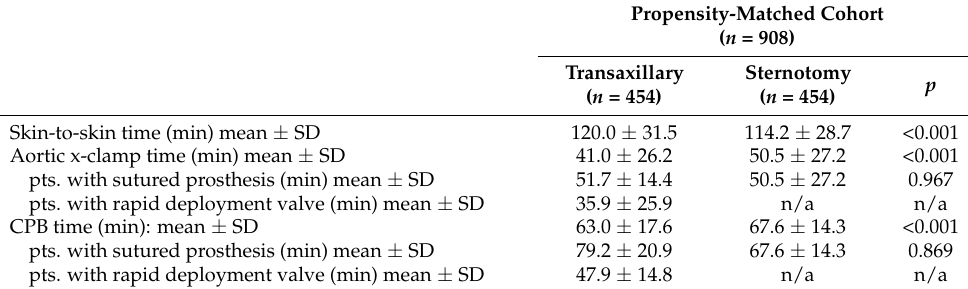
Table 3. Procedural